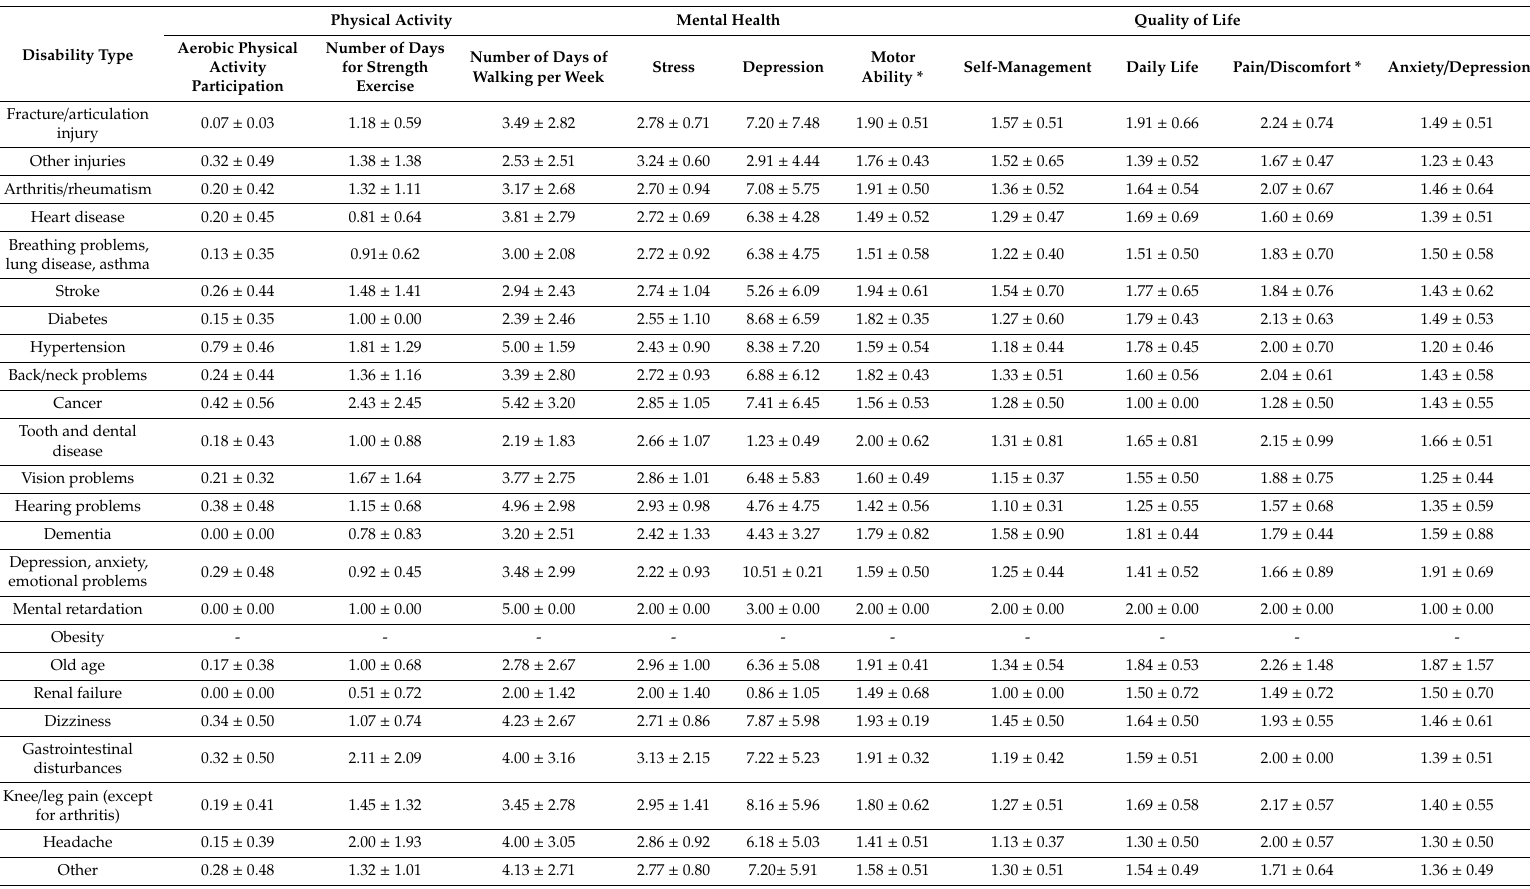
Table 4. Di ff erences in physical activity, mental health, and quality of life among the elderly based on medical